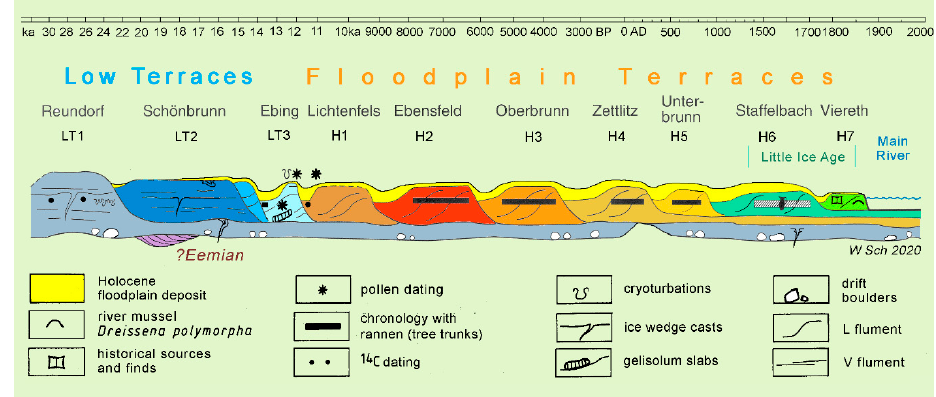
Figure 9. Terrace/flument row. Scheme along the Main River. From the Low Terrace 2 (LT 2) on, the river terraces of the valley floor form a terrace row. Occasionally, they get flooded (yellow), and therefore were called floodplain terraces. H = Holocene.